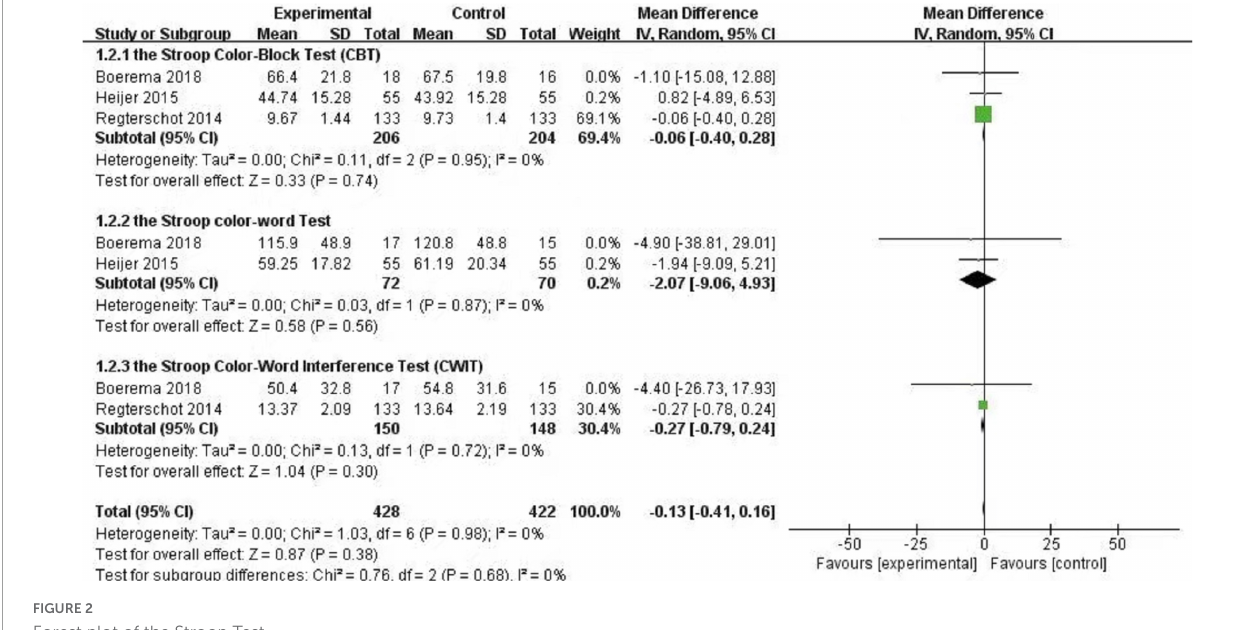
FIGURE2 Forest plot of the Stroop